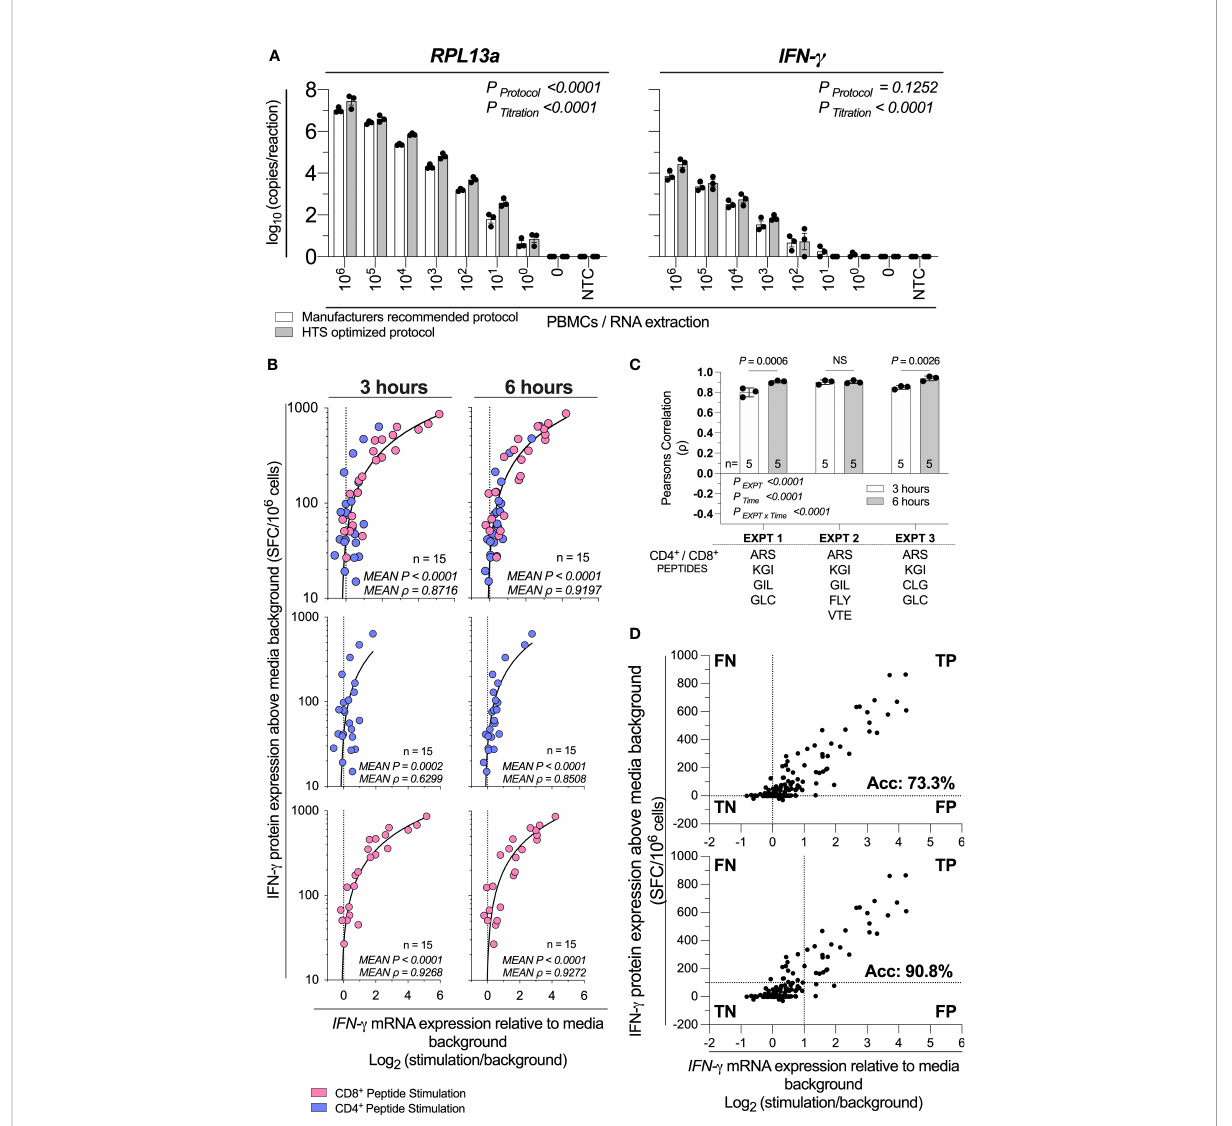
FIGURE 3 HTS-optimized RT-qPCR analytical and diagnostic sensitivity. (A) Assay analytical sensitivity of IFN- g and RPL13a mRNA copies per reaction from log 10 dilutions of unstimulated PBMCs from 10 6 to 0. Samples were tested alongside blank extraction control (0) and qPCR no template control (NTC). mRNA expression was determined by absolute-quantitative RT-qPCR with manufacturer ’ s recommended protocol (White Bars) or HTS optimized protocol (Grey Bars), with gene copy number per reaction normalized to log 10 copies per reaction. Biological replicates (n = 3), single RNA extractions, with single reverse transcription reactions per extraction were performed. Sample mean calculated from the mean of the technical triplicate qPCR reactions. Biological mean ± biological SEM shown. Signi fi cant differences due to protocol or PBMC titration were analyzed by two-way ANOVA. (B) IFN- g mRNA expression by RT-qPCR correlated to IFN- g protein production by ELIspot across 3-hours or 6- hours post-stimulation of PBMCs (1x10 5 ; n=15) stimulated with peptides representing two well-de fi ned CD4 + T cell peptide-epitopes (In fl uenza 57-71 KGI and In fl uenza 260-284 ARS; blue) and CD8 + T cell peptide-epitopes (In fl uenza 58-76 GIL and Epstein Barr Virus 280-288 GLC, Epstein Barr Virus 300-309 FLY, Epstein Barr Virus 300-309 VTE, or Epstein Barr Virus 300-309 CLG; pink). Shown are the mean gene copy number